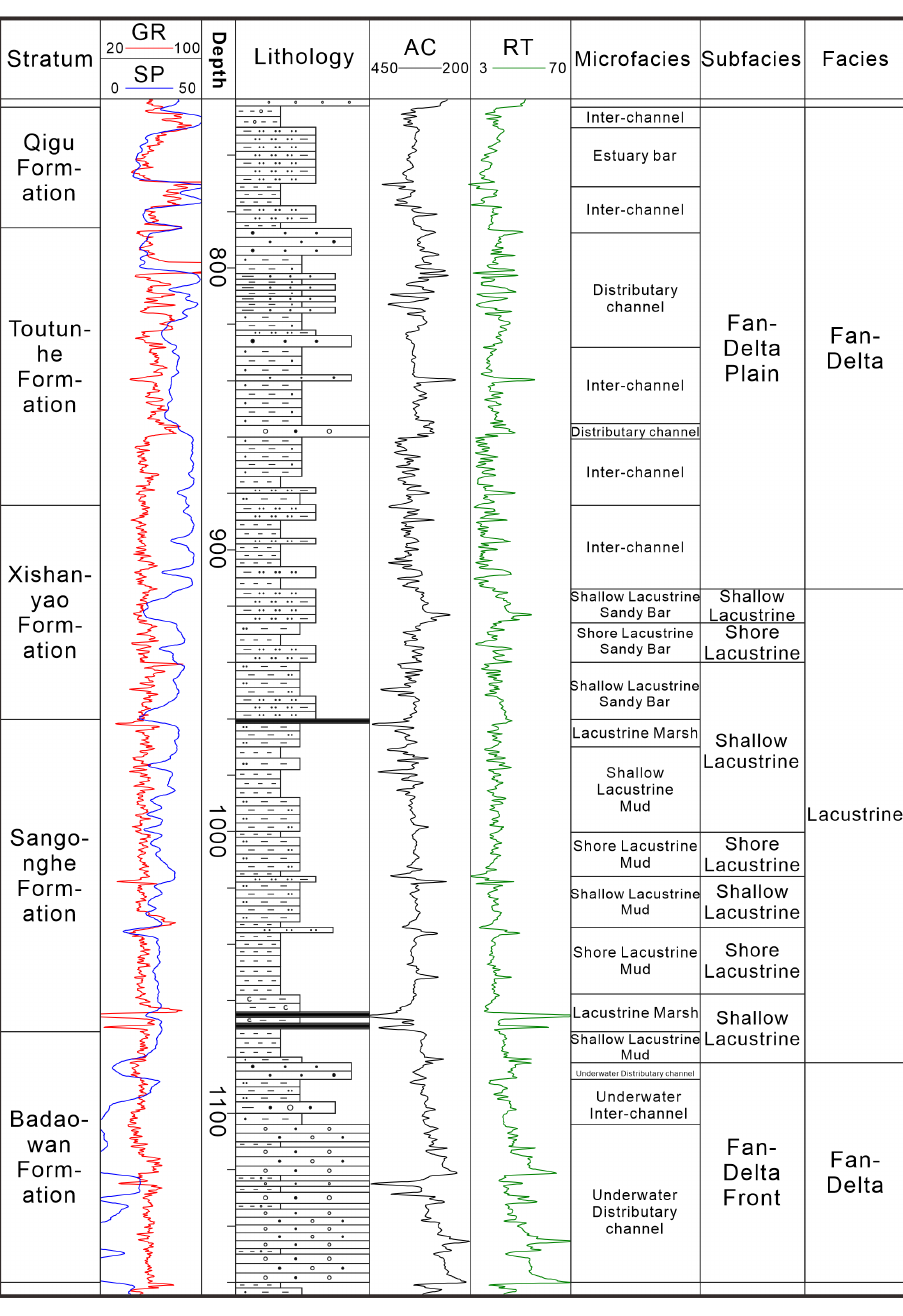
Figure 6. Single-well logging facies analysis of Well W105.